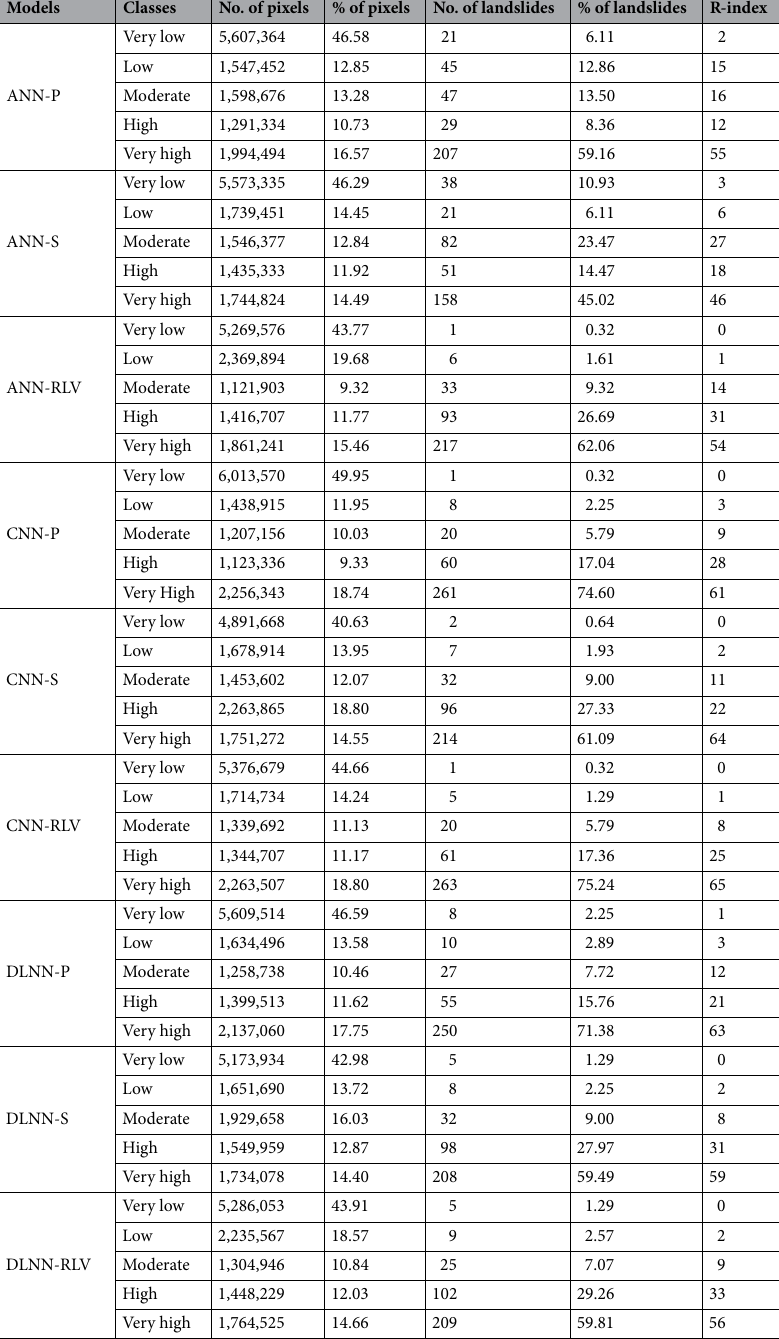
Table 4. Relative landslide density index of susceptibility classes of LSM